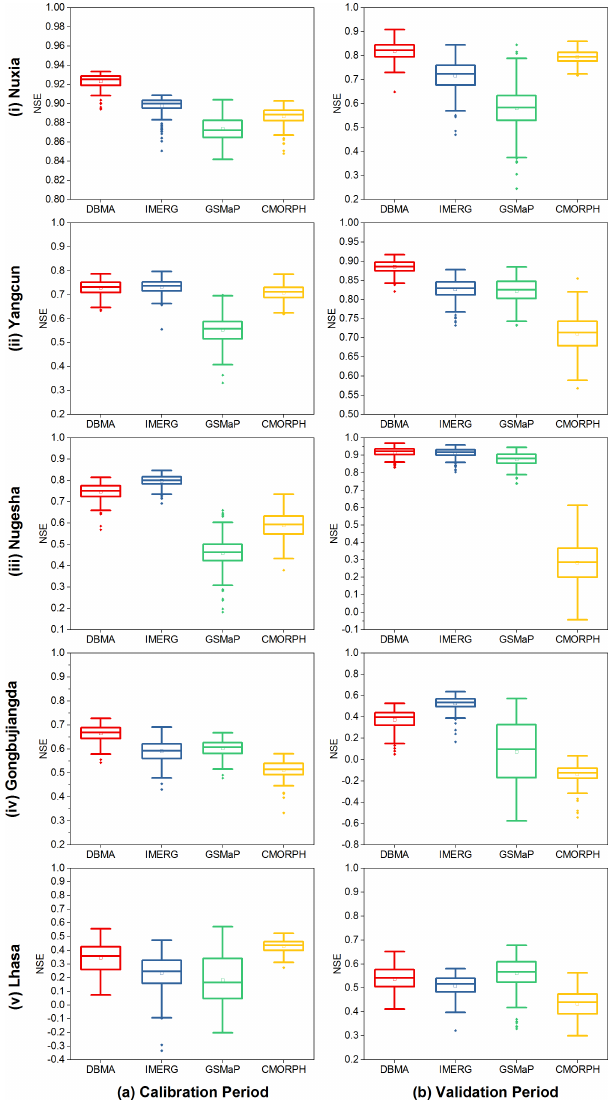
Figure 7. Runoff simulations at Nuxia, Yangcun, Nugesha, Gong- bujiangda and Lhasa stations forced by multiple rainfall inputs.